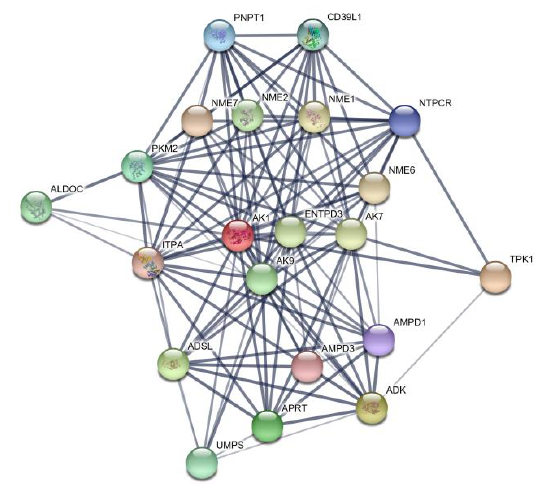
Figure 4. Protein network map of AK1 .